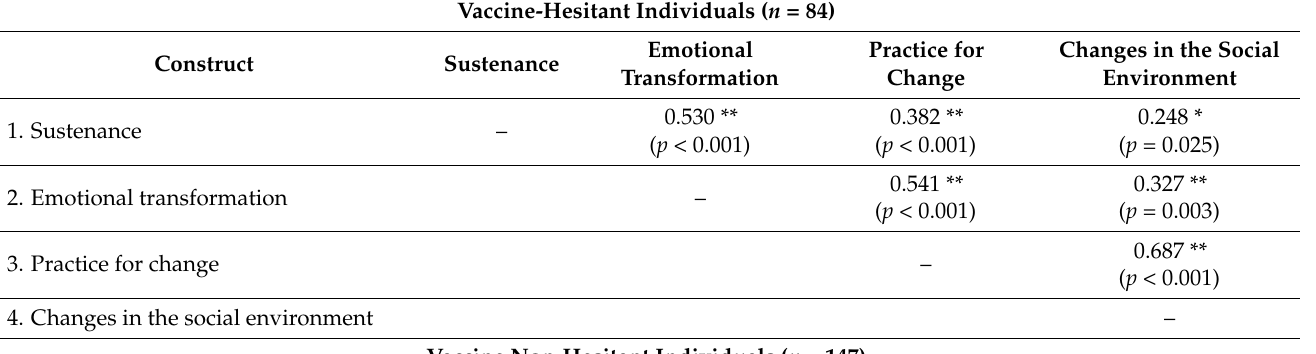
Table 4. Zero-order correlation matrix of study variables for the sustenance of COVID-19 vaccination